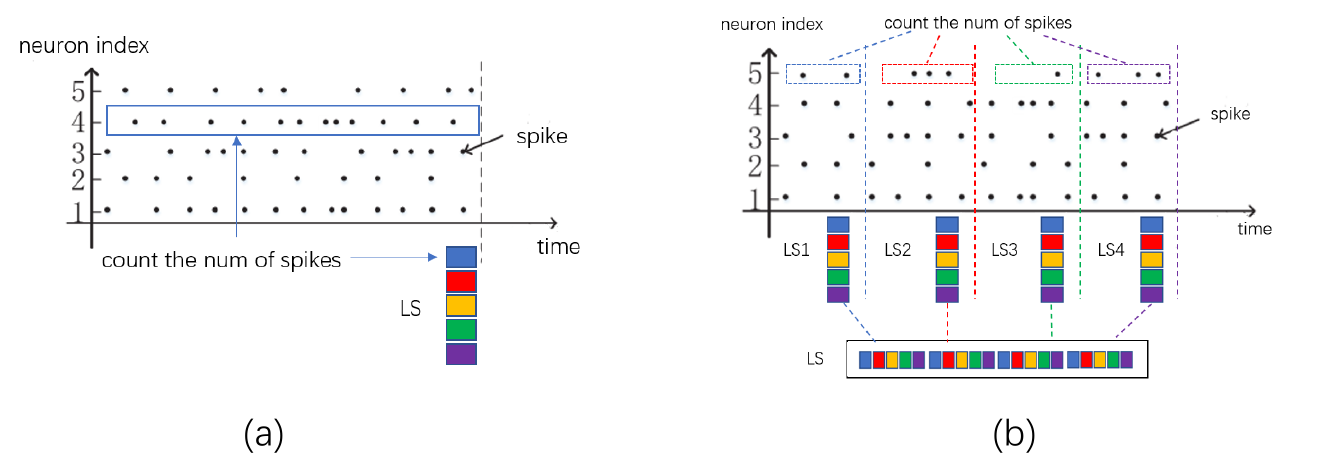
Figure 3. Two ways to generate the liquid state. ( a ) Traditional liquid state generation method. (LS represents the liquid state vector). ( b ) Time window division sampling technique.